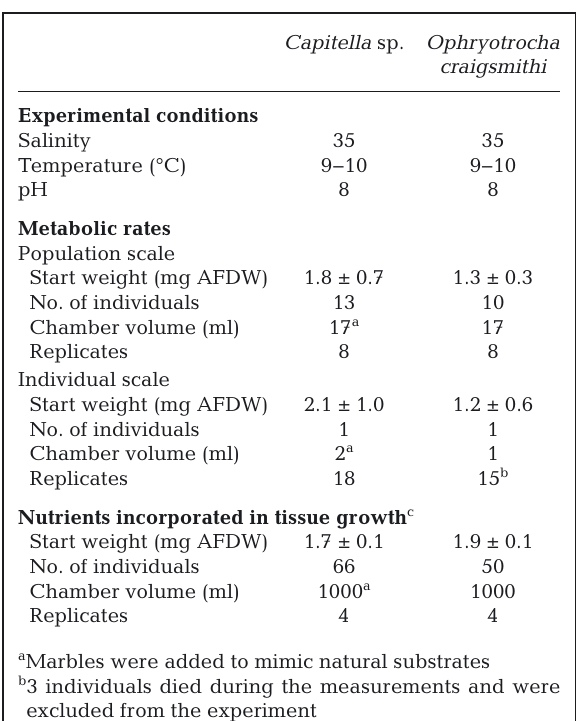
Table 1. Summary of the experimental set-up. AFDW: ash-free dry